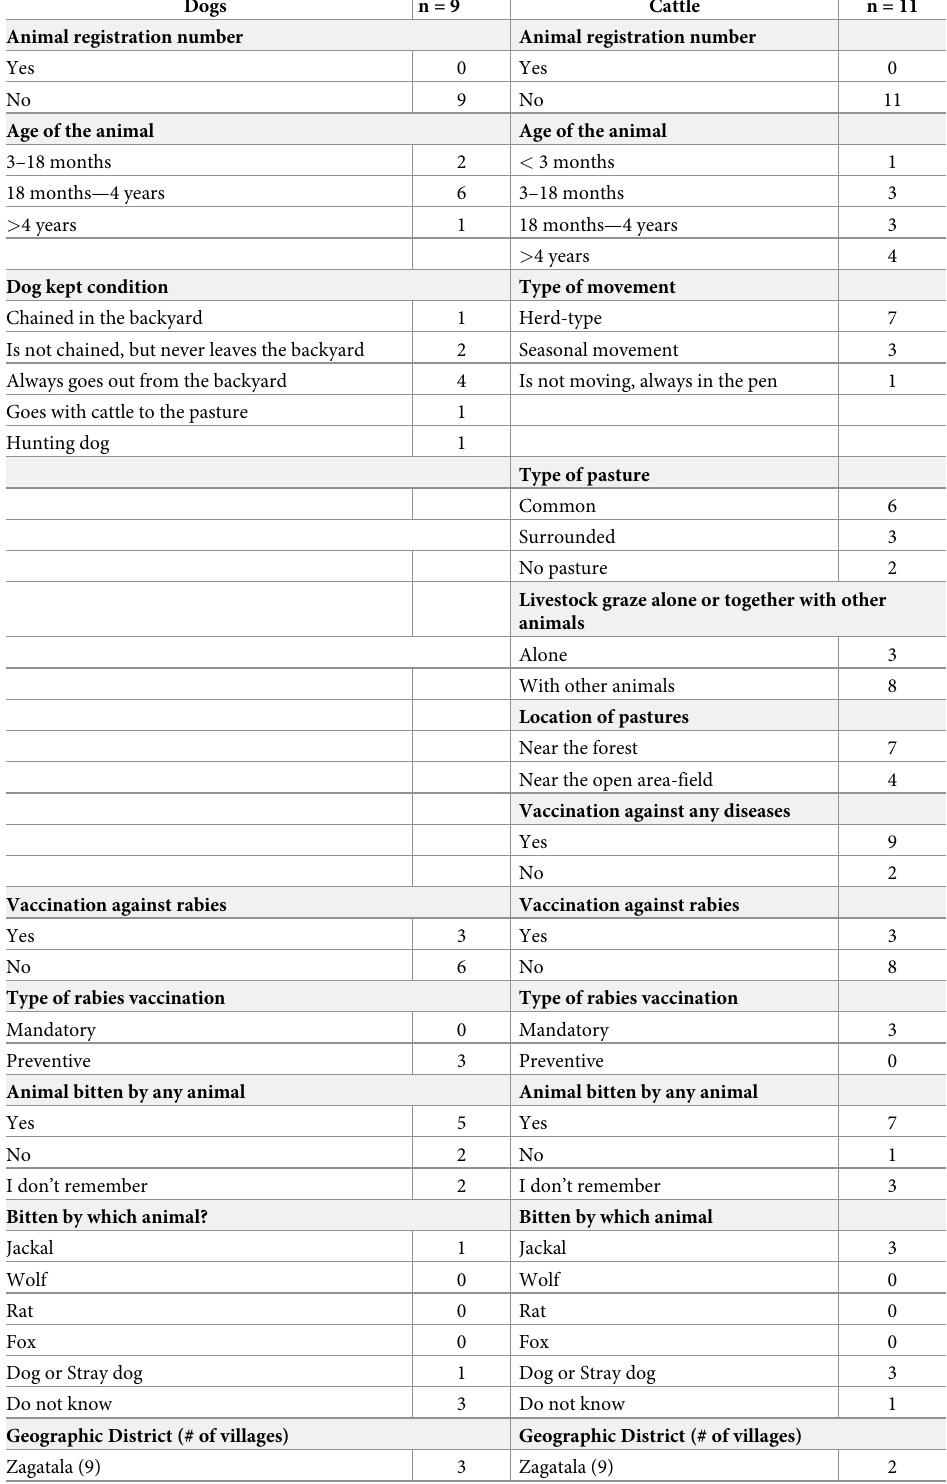
Table 1. Description of cases of rabies in dogs and